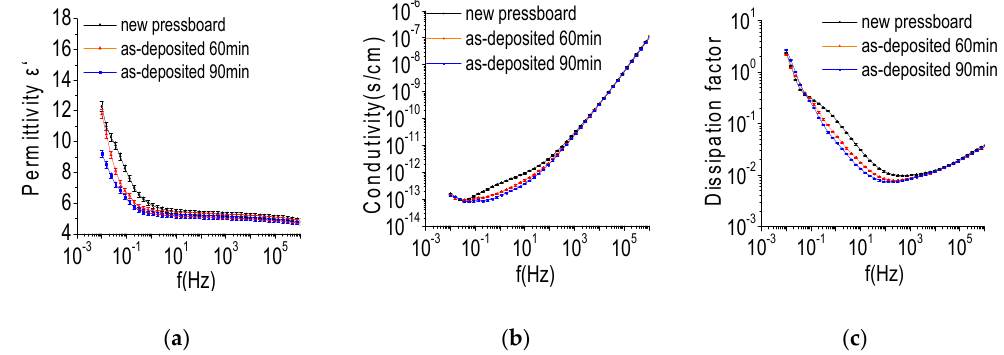
Figure 8. The ε ' r ( a ); conductivity ( b ) and tan δ ( c ) of the oil impregnated fresh pressboard, the oil impregnated pressboard surface sputtered Al 2 O 3 film for 60 and 90 min.